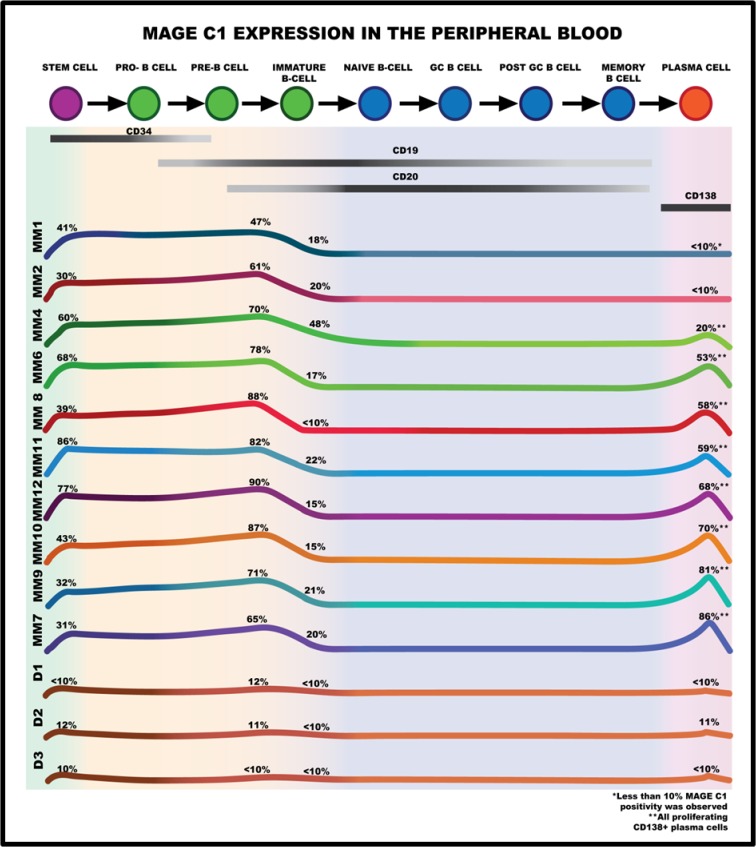
Schematic representation of the co-expression of B cell maturation markers and MAGE C1 in the relevant PB B-lymphocyte sub-populations of MM patients and donors.MAGE C1 expression was observed in the very early stages of B cell maturation involving the CD34+ and CD19+ as well as the proliferating plasma cells in the PB. Additionally no MAGE C1 expression was observed in the late B cells (CD20+) in the PB. The percentage indicated is the number of cells in a specific cell population expressing MAGE C1 (as defined by a specific cell-surface antigen). Kappa/Lambda light chain expression as well as CD117, CD10 and CD27 antibodies were not investigated in the PB. MM 1 to 12 as well as D1 to 3 indicates the different MM patient and donor profiles, respectively.